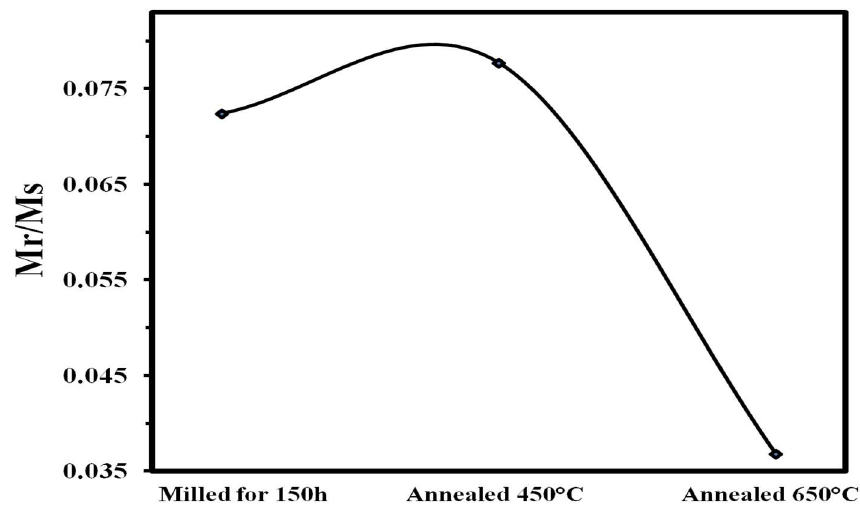
Figure 12. Values of the squareness ratio (M r /M s ) of Fe 70 Ni 12 B 16 Si 2 powders after milling for 150 h and heat treatment. and heat